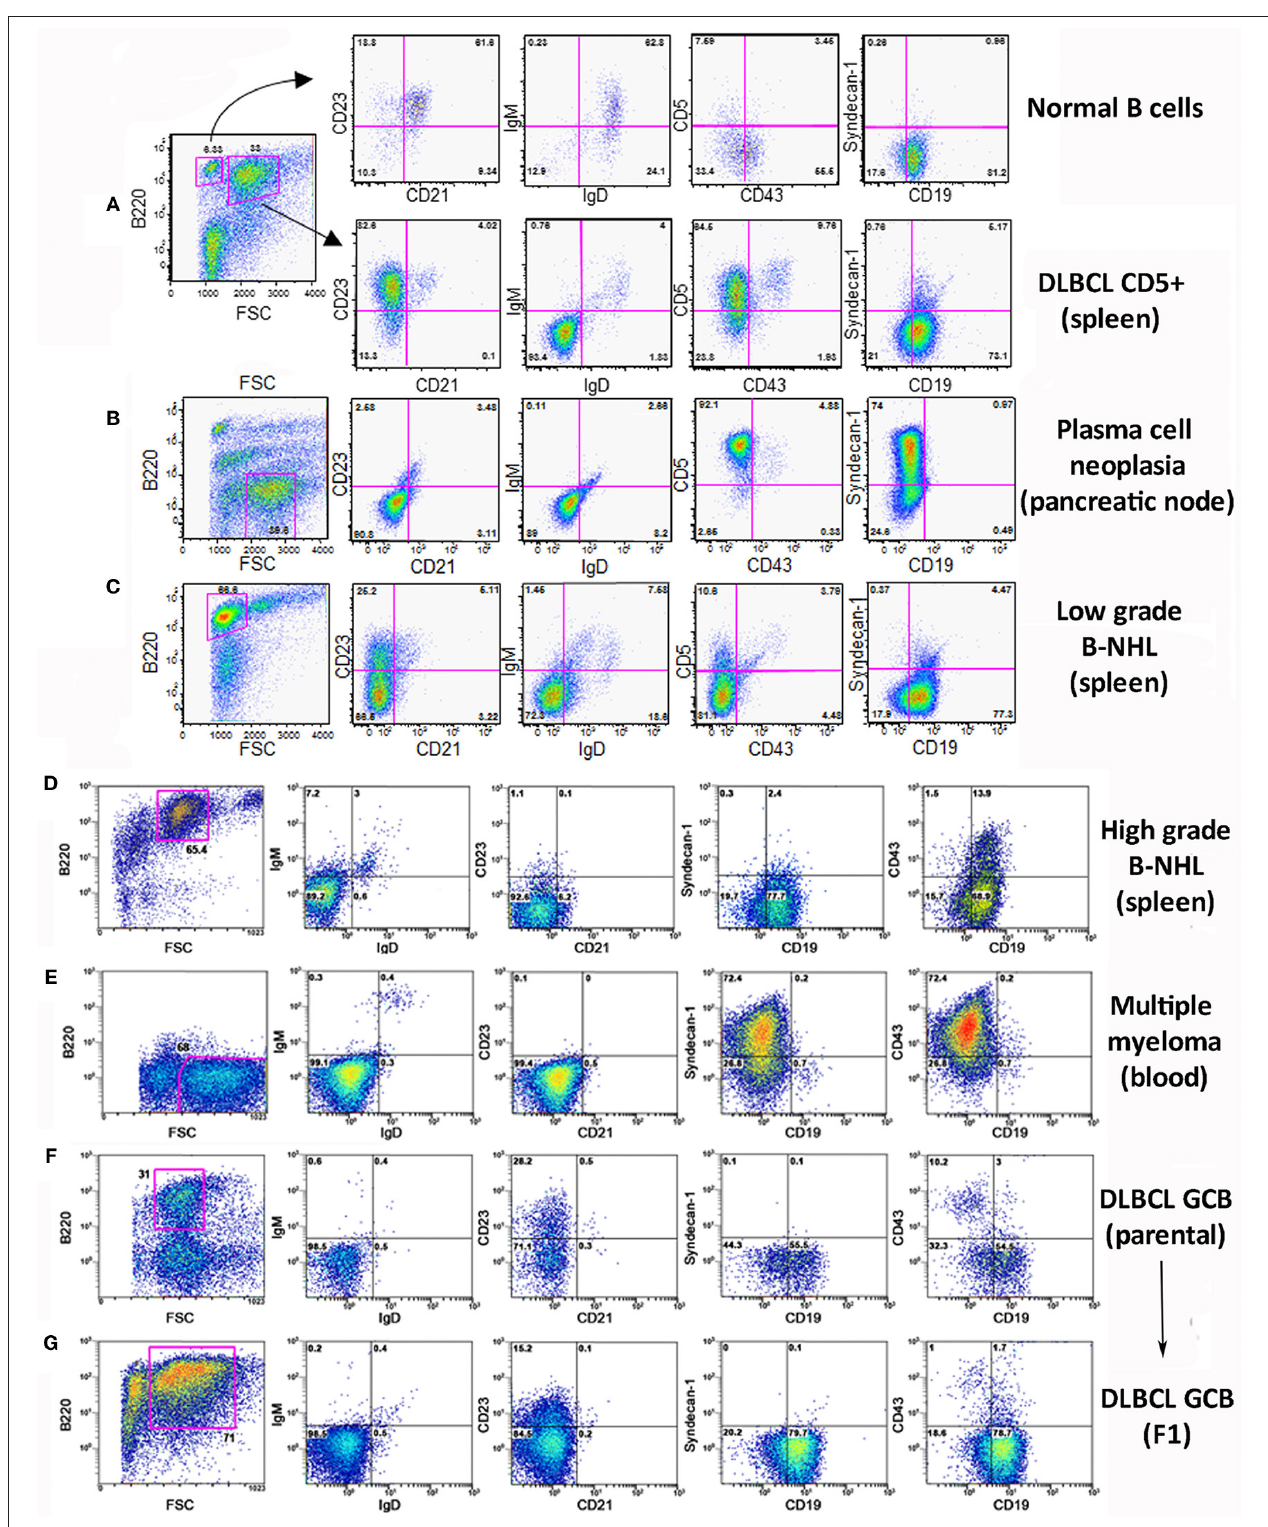
FIGURE 2 | Analysis of the B lymphocyte populations expanded in TRAF3/BCL2 double-tg mice with lymphoid dyscrasias. Three-color flow-cytometry analysis was performed to determine the phenotype of expanded B lymphocyte populations. Gating of the expanded population was based on the CD45R/B220 and FSC plot